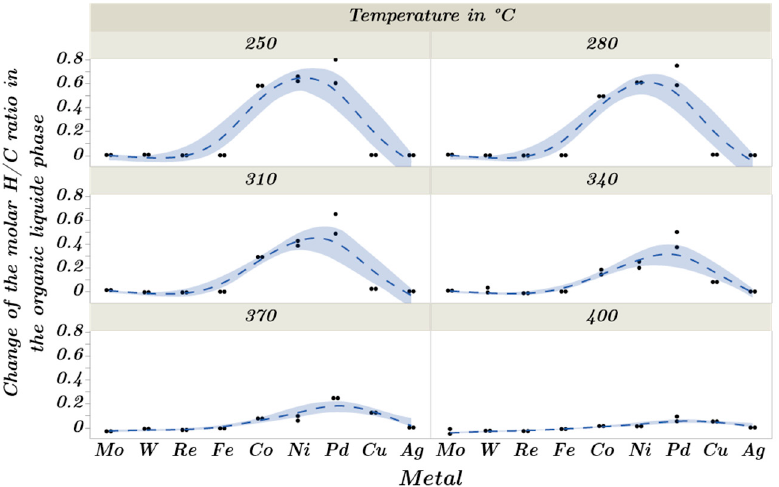
Figure 13. Change in the molar H/C ratio in the liquid phase compared to the starting material guaiacol (H/C = 1.14). A positive change results from an increase in the H/C ratio, i.e., hydrogenation. The dashed smoothing is based on a spline with λ = 0.05 and the confidence interval.